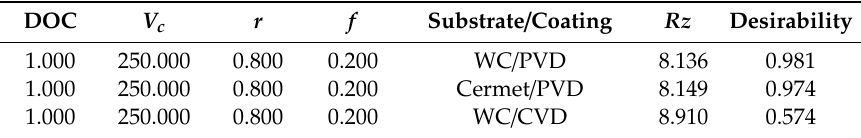
Table 14. Solutions of the Rz response